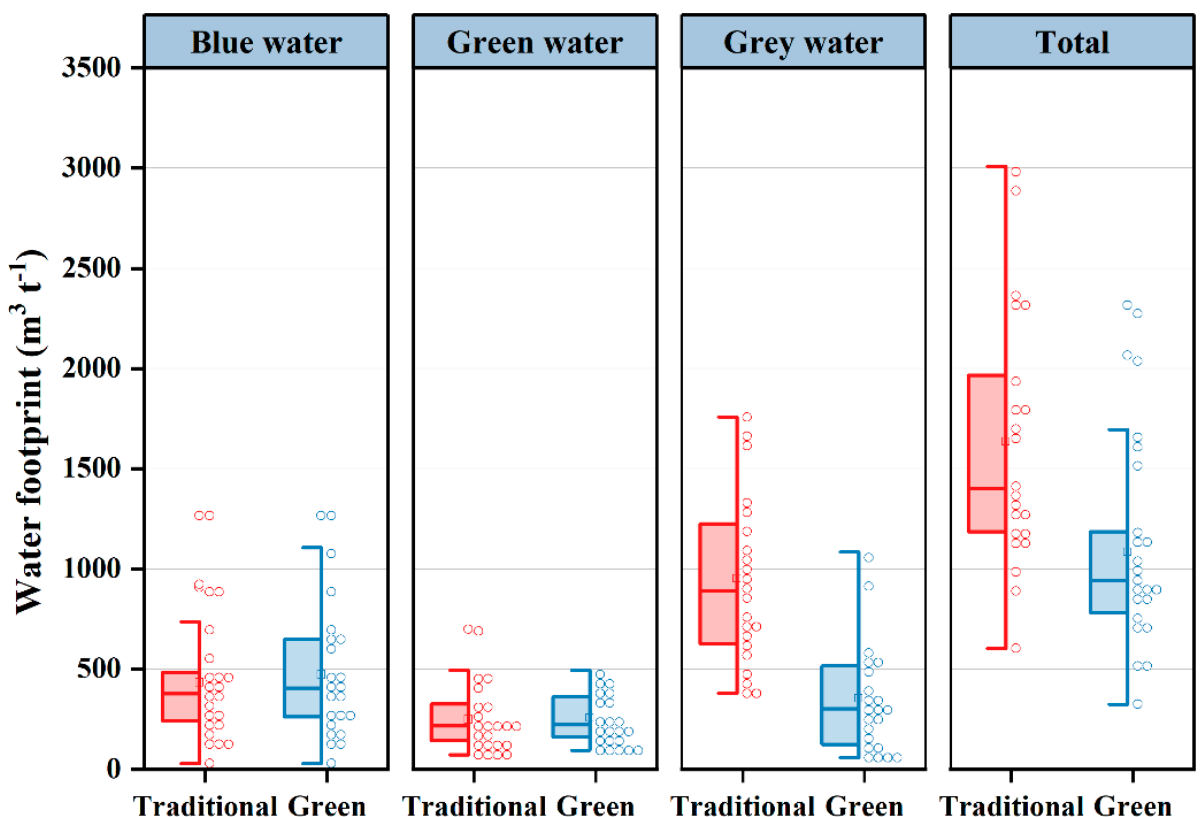
Figure 5. Crop water footprint of green and traditional cultivations in the Huang-Huai-Hai farming region. Boxplots indicate the 25, 50 (median) and 75 percentiles with horizontal lines joined into a box covering the central 50% of the data. Vertical lines above and below the box extend to outlier cutoffs, which go above and below the box by 1.5 times the 75–25 percentile range. The squares in the box indicate the mean. Circles indicate individual data.